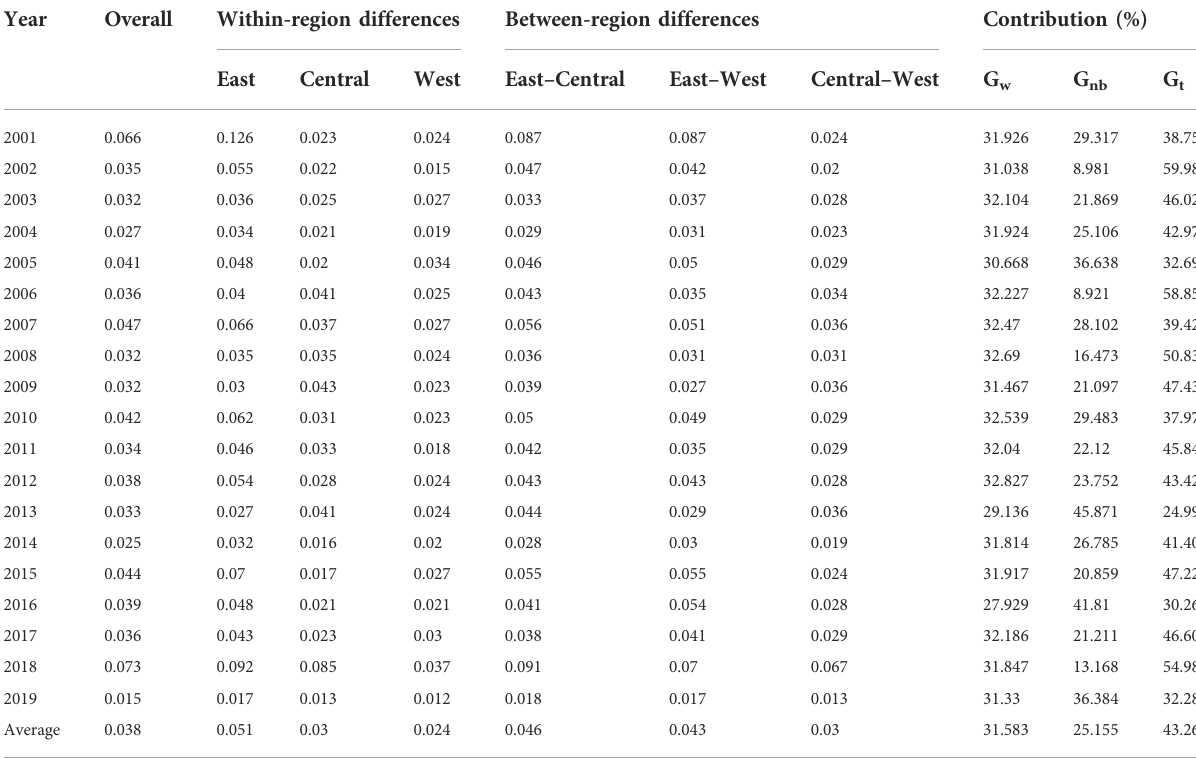
TABLE 4 National and regional Gini coef fi cients for GTFP difference in China and the contributions of each component of the decomposed Gini coef fi cient.